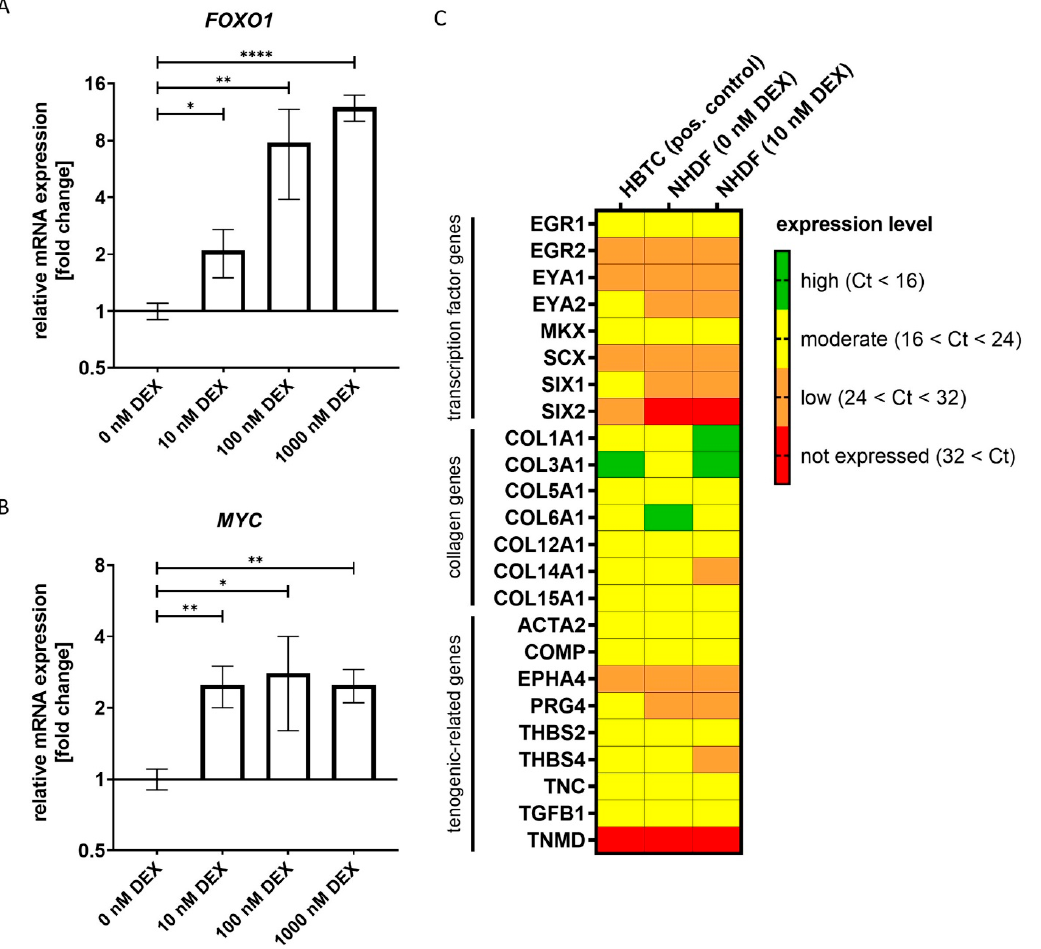
Figure 7. DEX- and tendon-related gene expression studies via quantitative PCR. ( A ) FOXO1 and ( B ) MYC relative mRNA expression ( GAPDH was used as reference gene) in d1 organoids of all groups. Bars show mean values ± SD for n = 3 donors; * p < 0.05, ** p < 0.01, **** p < 0.0001. ( C ) Heatmap visualizing the expression of tendon-related genes in 0 and 10 nM DEX-treated NHDF organoids in comparison to HBTC. Pilot analysis were performed at d14 of 3D maturation, n = 1 donor/group. Color scale indicates the expression levels based on thresholds defined by using the Ct values of the housekeeper genes GAPDH , HPRT and B2M as follows: (1) high expression, Ct value lower than the one of B2M (Ct < 16); (2) moderate expression, Ct value in between B2M and GAPDH (16 < Ct < 24); (3) low expression, Ct value between GAPDH and HPRT1 (24 < Ct < 32); (4) not detectable/not expressed, Ct > 32.